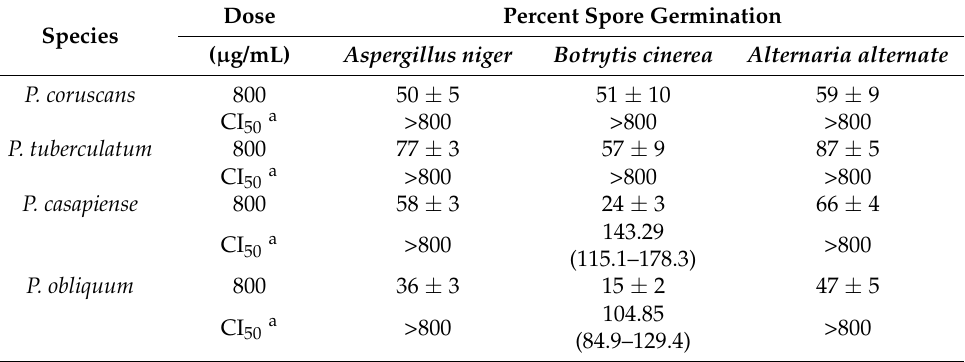
Table 3. Antifungal activity (% spore germination) against Aspergillus niger , Botrytis cinerea, and Alternaria alternate .